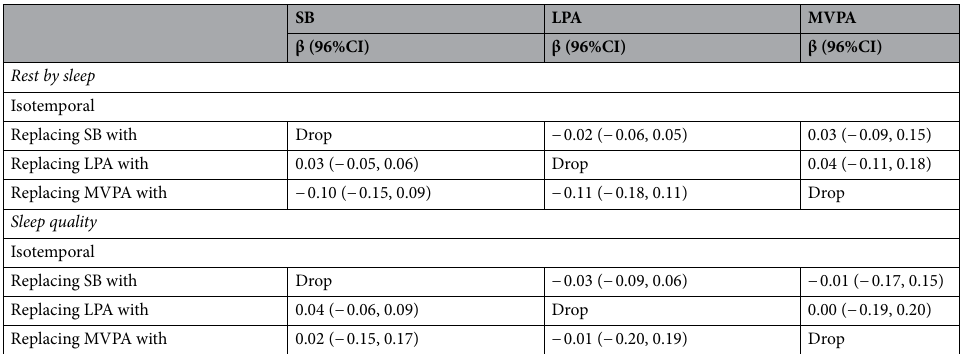
Table 4. Isotemporal models examining the associations of SB, LPA, and MVPA with sleep measures in men (n = 263). Regression coefficients correspond to a 60 min/day increment of each activity. All models were adjusted for age, education, marital status, body mass index, living status, income, working status, and smoking. The single-activity and isotemporal models also were adjusted for the accelerometer daily wear time. SB sedentary behaviour, LPA light-intensity physical activity, MVPA moderate-to-vigorous physical